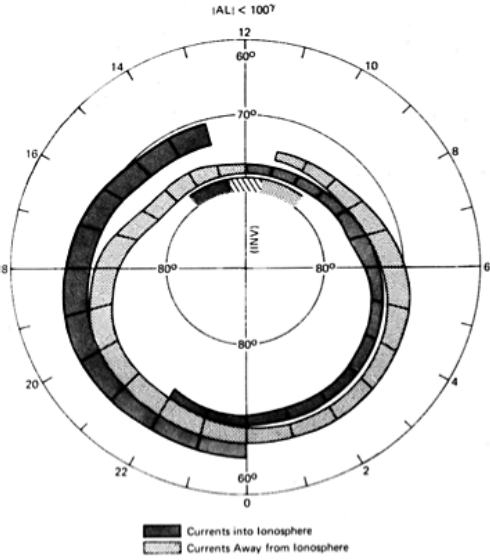
Figure 7. A pattern of the distribution of large-scale field-aligned currents (Fig. 6 from Iijima and Potemra, 1976b) determined from TRIAD data for weakly disturbed conditions. The “hatched” area in the polar cusp region corresponds to unclear current flow